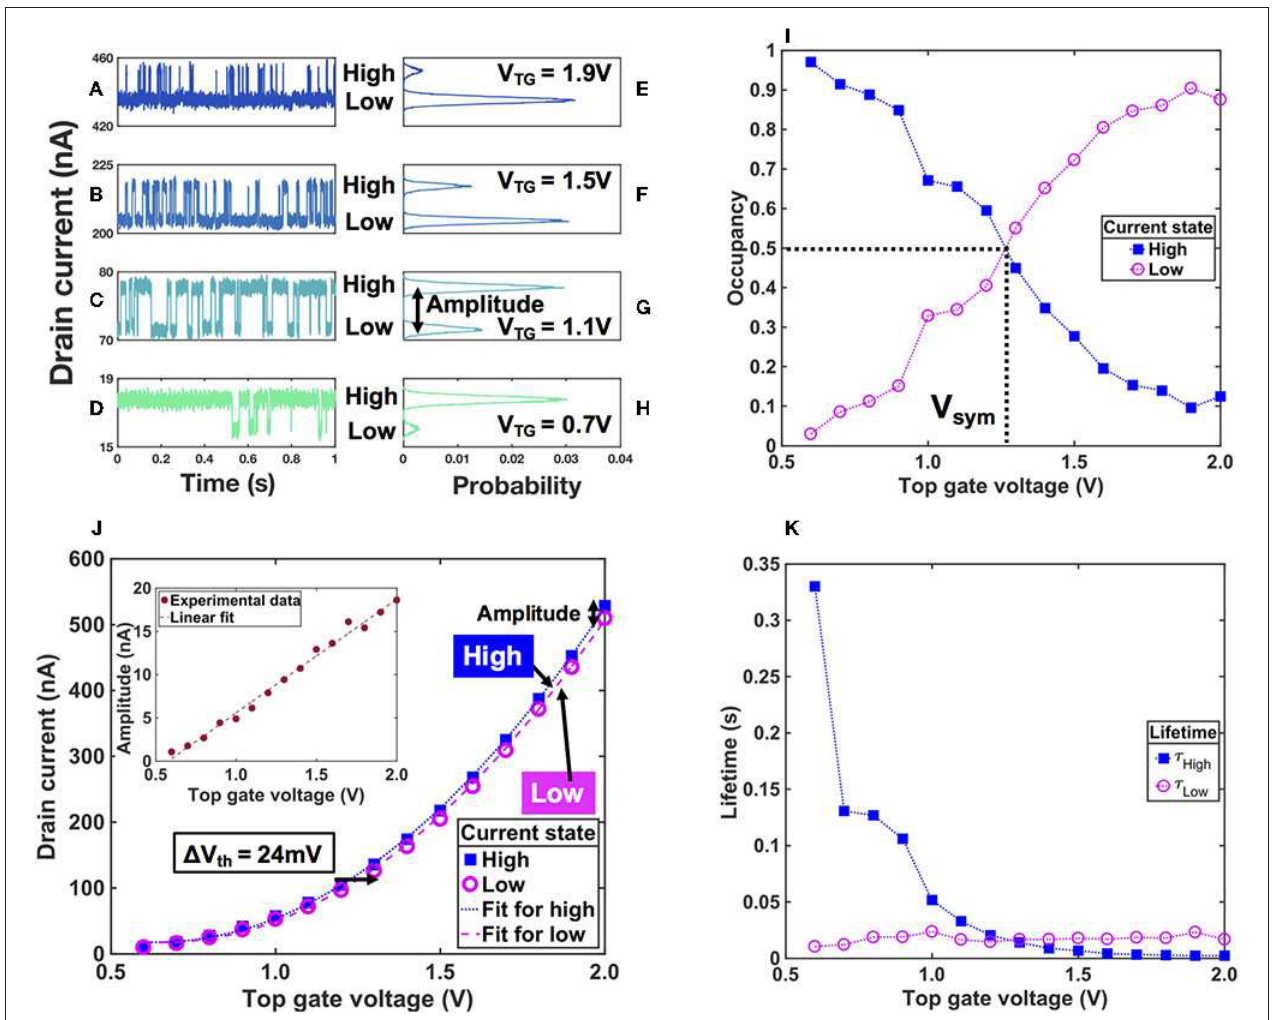
FIGURE 3 | Time domain characteristics of the silicon nanowire transistor and properties of the observed random telegraph signals. (A–D) Examples of the time domain characteristics of the device. I D was monitored for one second at different voltage conditions. V FG and V D were 0 V and 200 mV, respectively, while V TG was 1.9 V in (A) , 1.5 V in (B) , 1.1 V in (C) , and 0.7 V in (D) . Two discrete current states are clearly seen in all measurements and are labeled as high and low. (E–H) The histograms of the corresponding time domain characteristics (E) for (A) , (F) for (B) , (G) for (C) , and (H) for (D) . (I) The occupancy of the QD against V TG ,